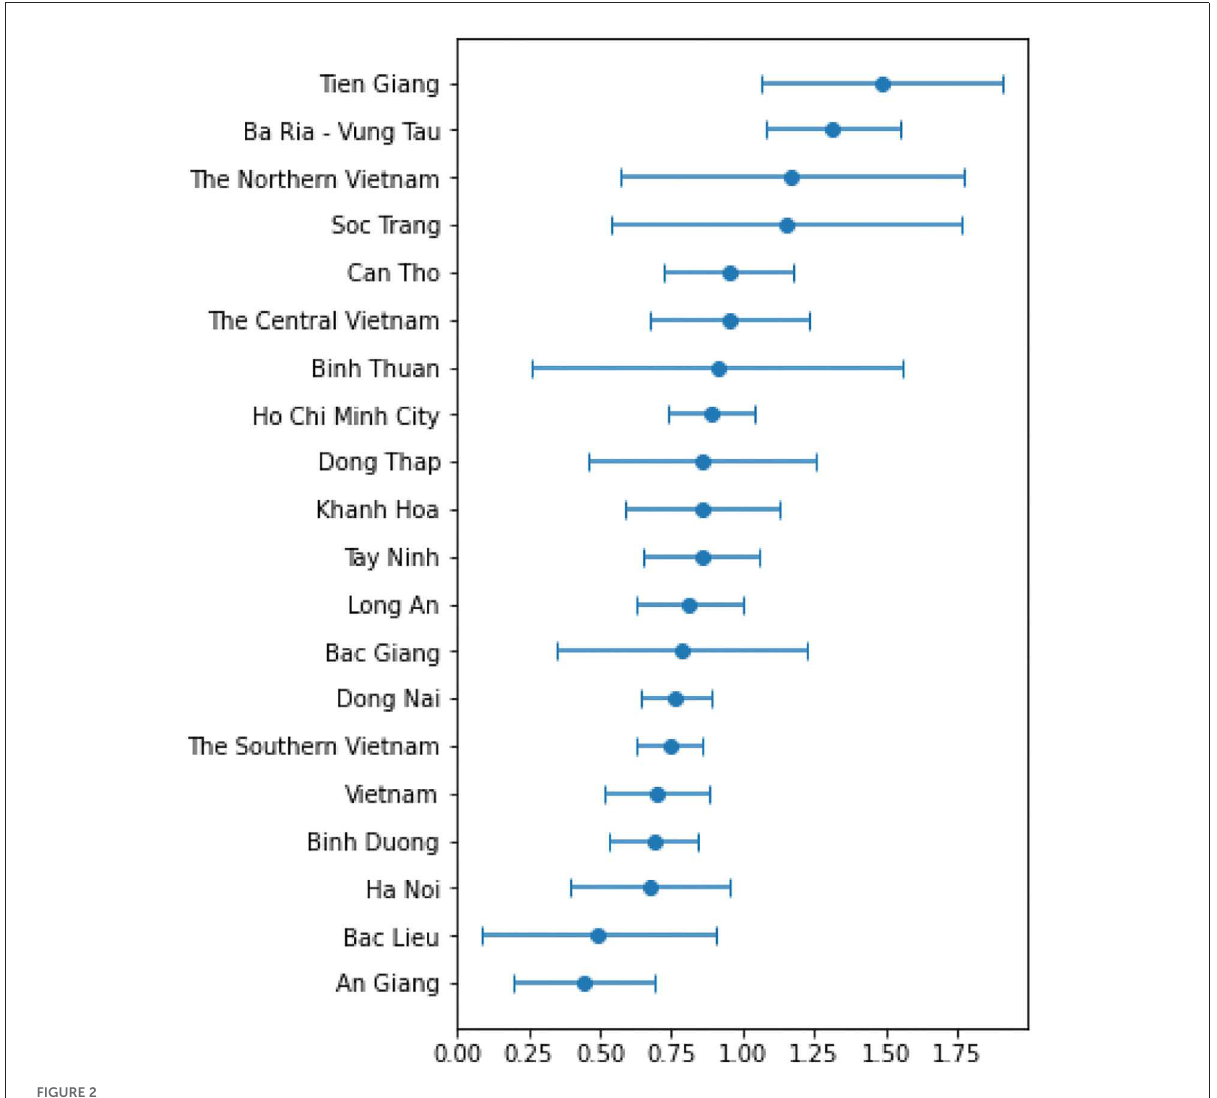
FIGURE2 Slope results of MR i